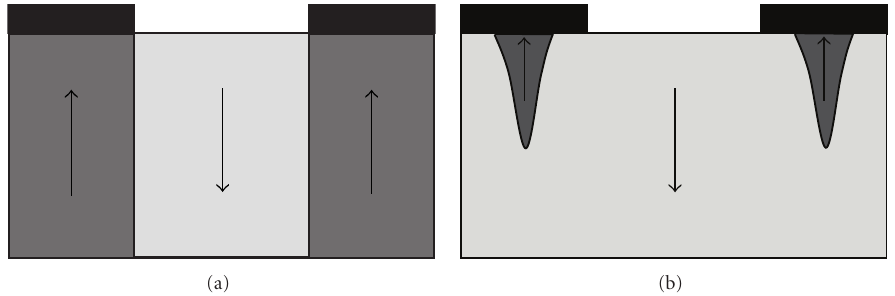
Figure 2: (a) Bulk periodic poling and (b) surface periodic poling.